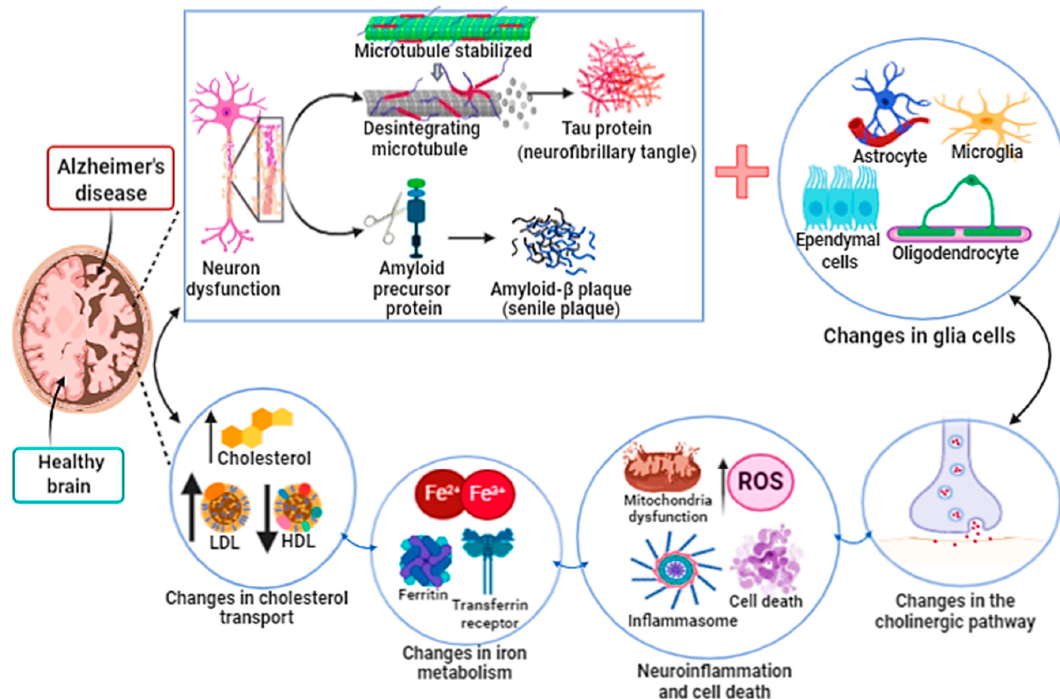
Figure 4. Alzheimer’s disease. The development and progression of Alzheimer’s disease (AD) lead to atrophy, loss and dysfunction of both neurons and glial cells. AD begins in the dorsal raphe nucleus with subsequent progression to the cortex, which is the center of information processing and memory storage. The factors that promote the development of AD are still unknown. However, it seems that the intracellular accumulation in neurons of the phosphorylated Tau protein (neurofibrillary tangle) and the formation of amyloid-B plaque (senile plaque) in the extracellular environment and brain tissue both lead to neuron loss and dysfunction. In addition, the formation of neurofibrillary tangle and senile plaque alters the functions of glial cells, such as oligodendrocytes (responsible for the myelination of neurons), microglia cells (phagocytic cells) and astrocytes (responsible for the absorption and exchange of nutrients between neurons and blood vessels). Dysregulation of cholesterol transport and iron metabolism in the central nervous system contributes to poor prognosis of Alzheimer’s disease. All these associated factors lead to an increase in neuroinflammation and oxidative stress associated with mitochondrial dysfunction, compromising the production of ATP, altering the concentration of neurotransmitters in the synaptic cleft, finally promoting cell death. Evidence of the association between the accumulation of iron in the cerebral cortex and the development of Alzheimer’s disease emerged in the early 1960s [140,141]. Since then, several studies have demonstrated the direct association between free iron, oxidative stress, lipid peroxidation and cell death of neurons, usually associated with apoptosis and/or necrosis, due to increased neuroinflammation. The iron dyshomeostasis is associated with ROS production and neurodegeneration in AD [138]. Furthermore, aging and changes in iron metabolism are associated with the development of A β plaques and NFTs. Svobodová et al. [142] demonstrated in an APP/PS1 transgenic mice model that free iron and ferritin accumulation follows amyloid plaque formation in